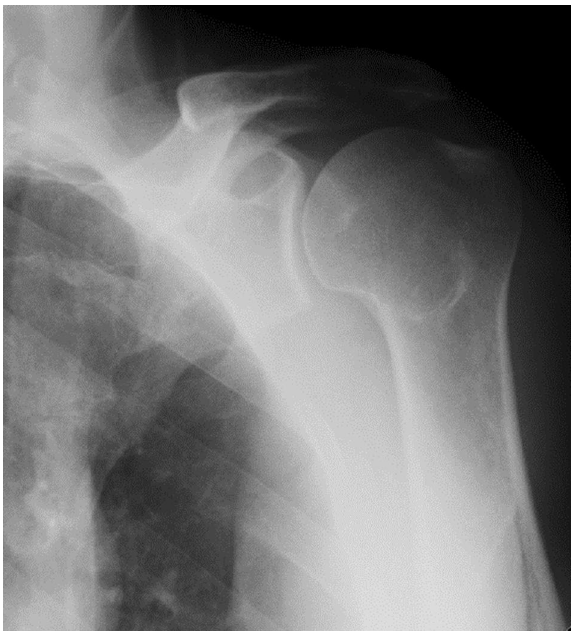
Figure 1. The figure shows the anteroposterior radiograph of Samilson-Prieto grade 0